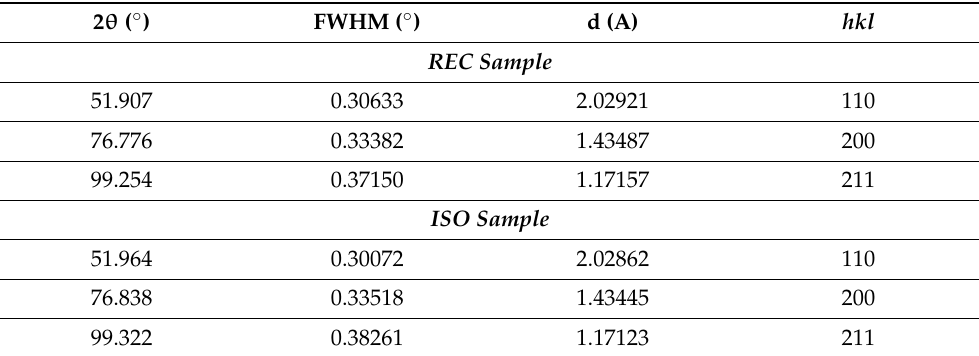
Table 5. Parameters obtained from the XRD analysis in the heat-treated samples.